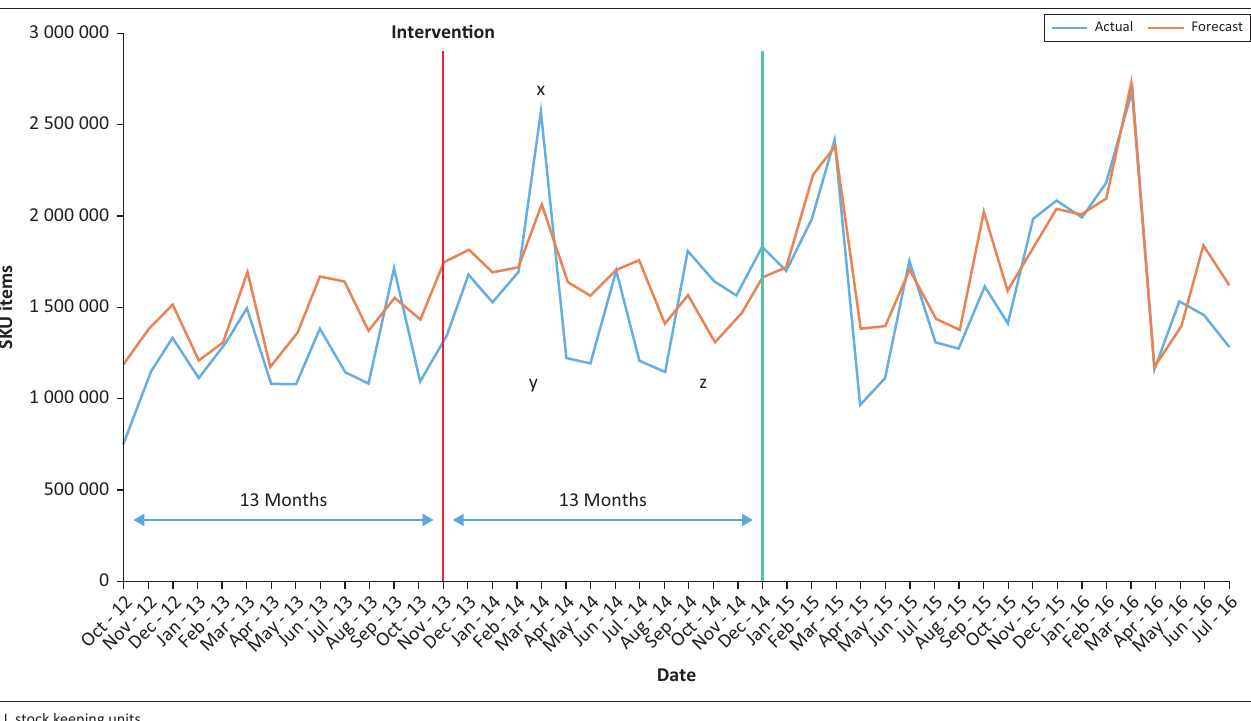
FIGURE 2: Forecast accuracy assessment for all 443 stock keeping units.